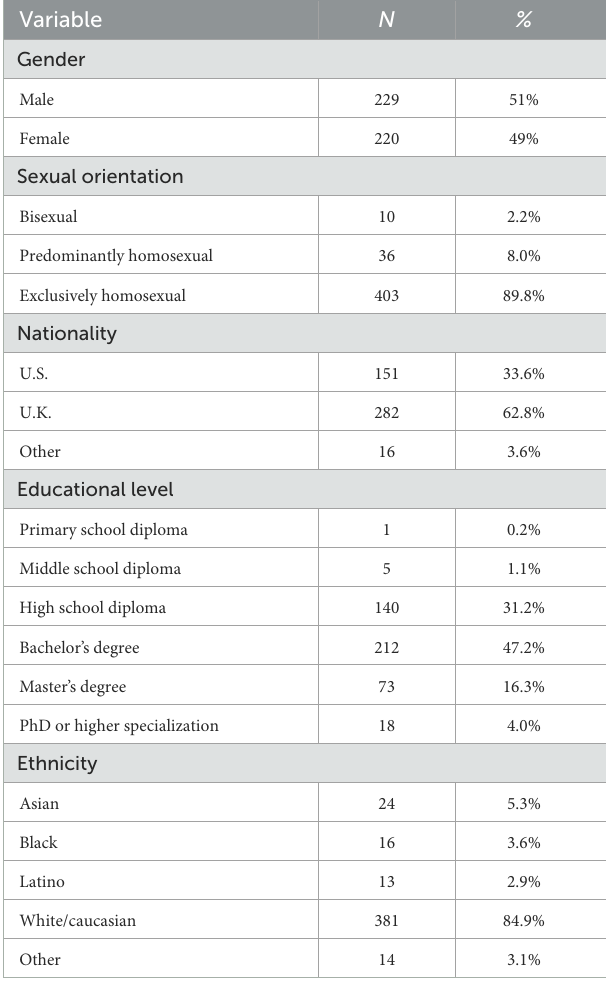
TABLE 1 LGB sample’s descriptives ( N =